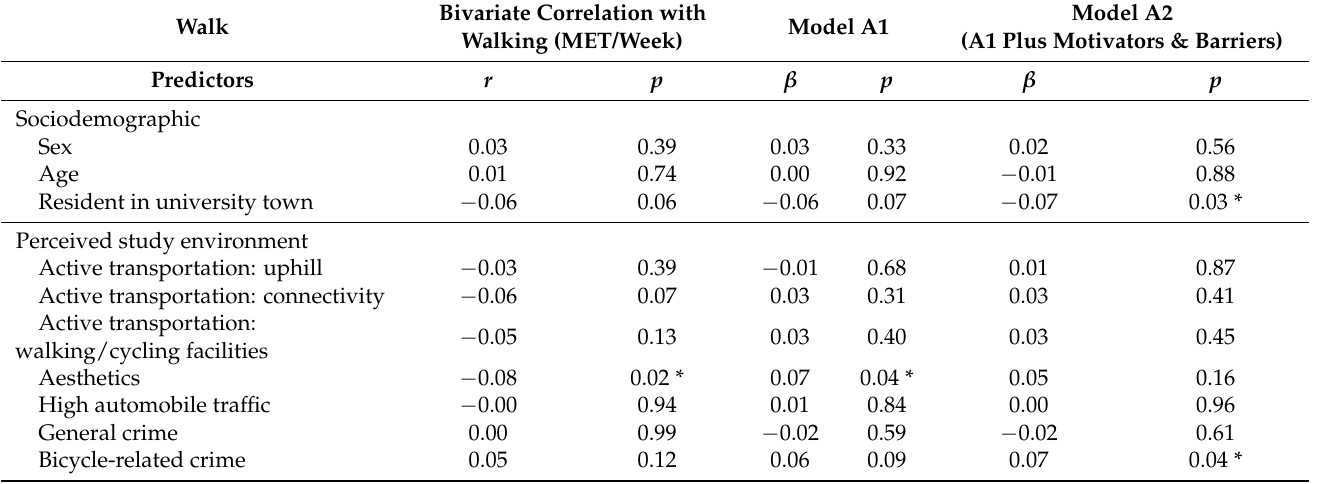
Table A7. Results (inter-item-correlation-coefficients r, β-coefficients and significant p -value) for the bivariate correlation and multivariate regression models A1 (sociodemographics and perceived study environment) and A2 (A1 plus Motivators & Barriers) for the transportation mode “walk”.